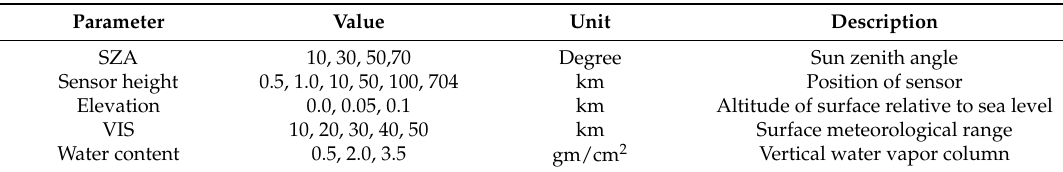
Table 1. Input parameters of MODTRAN used in the generation of simulated